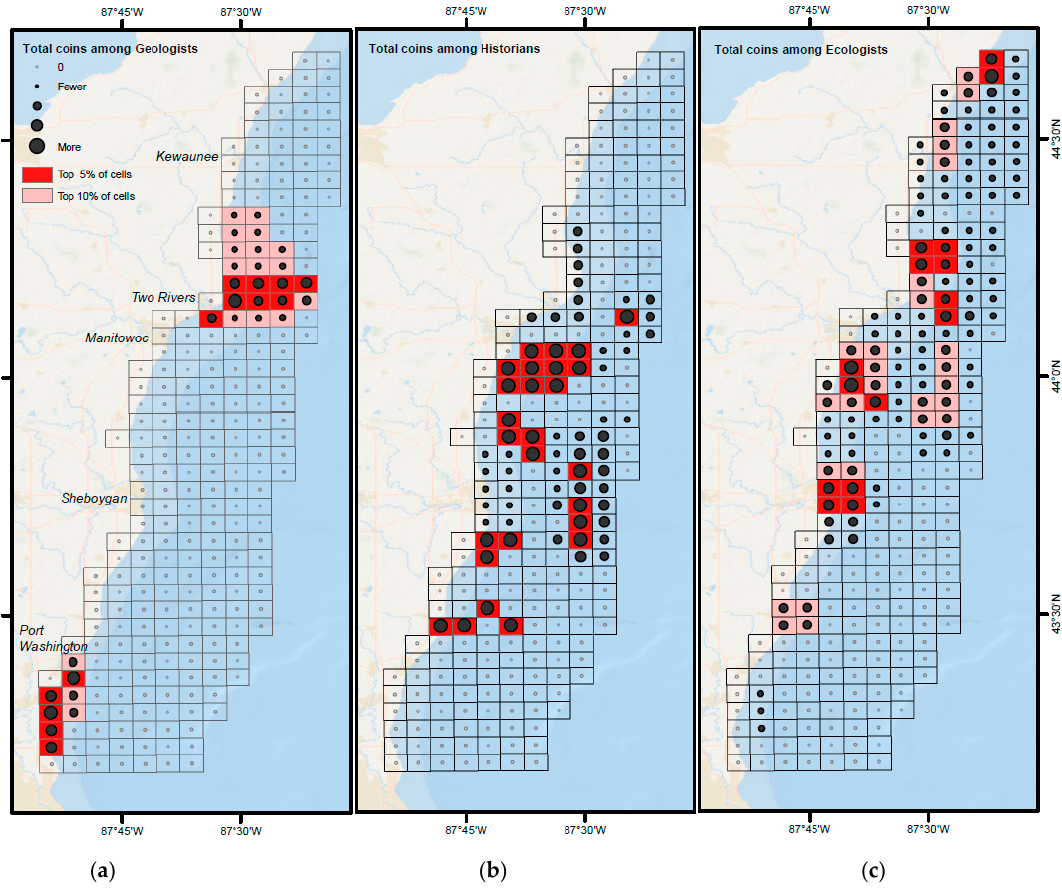
Figure 4. Sum of all coins in each cell among respondents with expertise in the field of ( a ) geology; ( b ) history; and ( c ) ecology. Note that the top 5th and 10th percentile include the same cells for historians, due to the large number of ties in cell value (thus, no pink cells are visible).